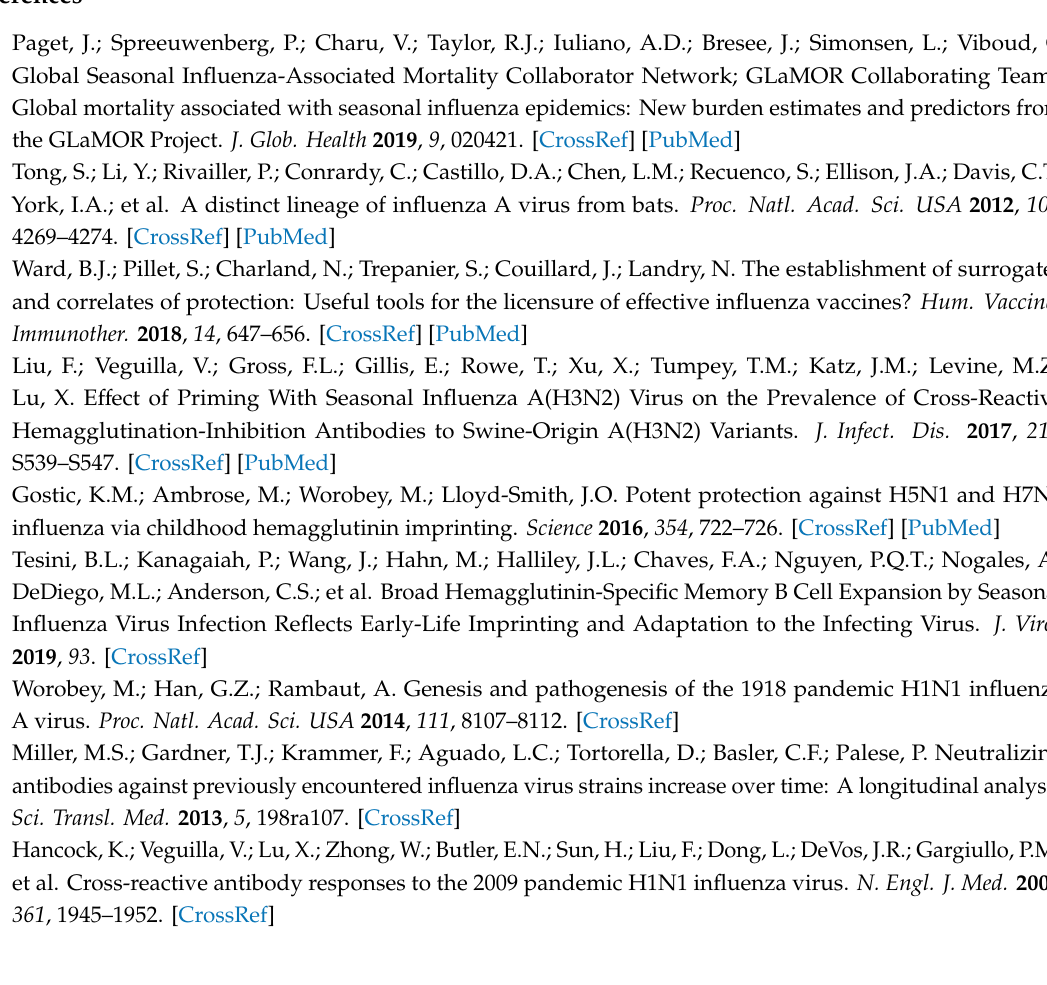
Table S1. Pre-immune ferret studies with only A(H1N1) and Type B influenza in published peer-reviewed literature. Legend: Underlined = Vaccination; Bold = Live infection; TIV = Trivalent inactivated vaccine; LAIV = Live attenuated influenza vaccine; IIV = Inactivated influenza vaccine; VLP = virus-like particle, Table S2. Pre-immune ferret studies with A(H1N1), A(H3N2), and Type B influenza in published peer-reviewed literature. Legend: Underlined = Vaccination; Bold = Live infection; TIV = Trivalent inactivated vaccine; LAIV = Live attenuated influenza vaccine; IIV = Inactivated influenza vaccine; VLP = virus-like particle, Table S3. Pre-immune ferret studies with only A(H3N2) and Type B influenza in published peer-reviewed literature. Legend: Underlined = Vaccination; Bold = Live infection; TIV = Trivalent inactivated vaccine; LAIV = Live attenuated influenza vaccine; IIV = Inactivated influenza vaccine; VLP = virus-like particle, Table S4. Pre-immune ferret studies with A(H5N1) influenza in published peer-reviewed literature. Legend: Underlined = Vaccination; Bold = Live infection; TIV = Trivalent inactivated vaccine; LAIV = Live attenuated influenza vaccine; IIV = Inactivated influenza vaccine; VLP = virus-like